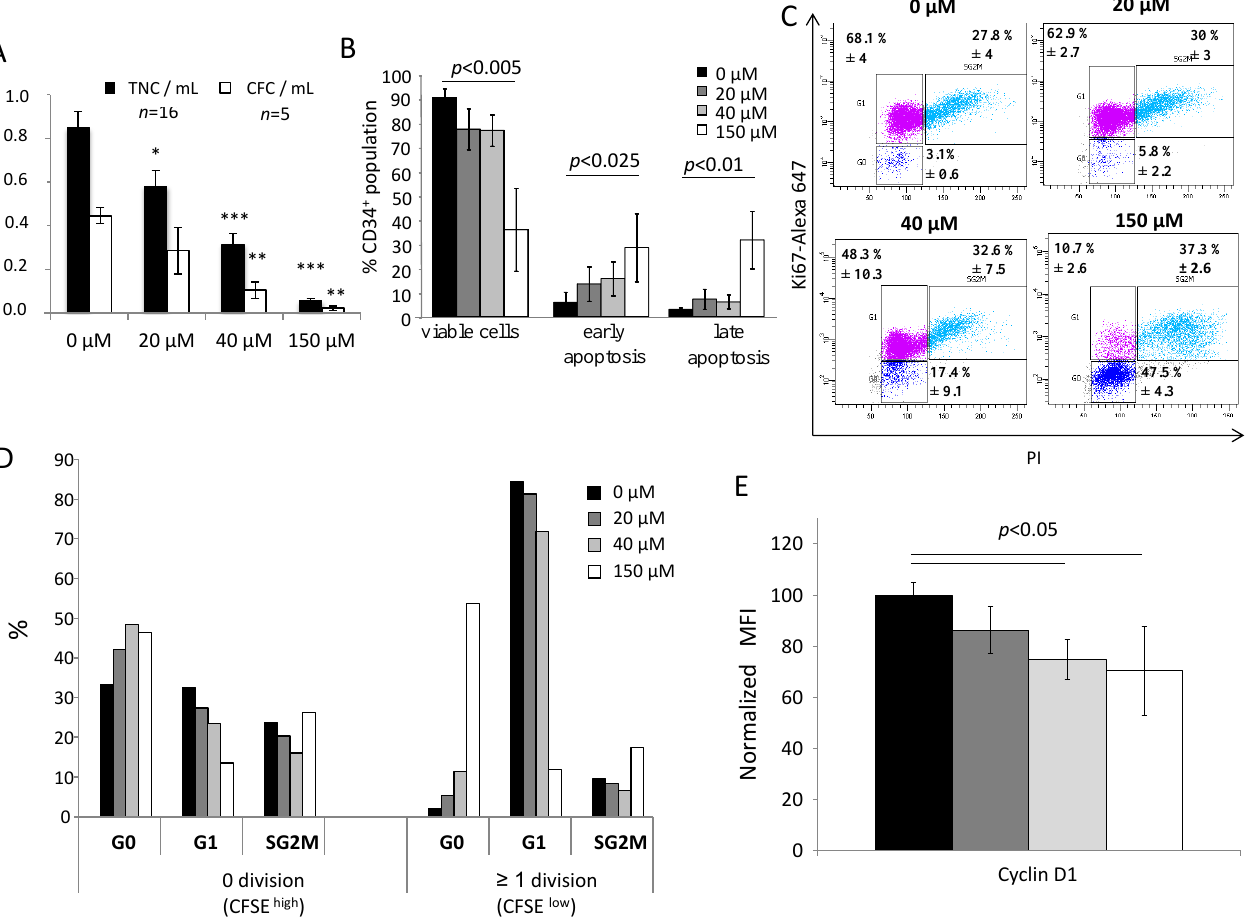
Figure 1. Influence of α TOA on proliferative kinetics and the cell cycle of CD34 + and committed progenitor cells. ( A ) α TOA inhibits the amplification of total nucleated cells (TNC) and committed progenitors (CFC) after 3 days of primary culture. *: p < 0.025, **: p < 0.01 and ***: p < 0.001 in comparison to the 0 µ M condition. ( B ) Cell viability of CD34 + cells after 3 days of primary culture, n = 6. ( C ) Cell cycle labelling shows an accumulation of CD34 + cells in the G0 phase after 3 days of α TOA treatment, n = 6. ( D ) The G0 accumulation increases with α TOA concentration. n = 2. ( E ) α TOA inhibits cyclin D1 after 3 days of culture n = 5. Data presented in ( A , B , C , E ) are means +/ −